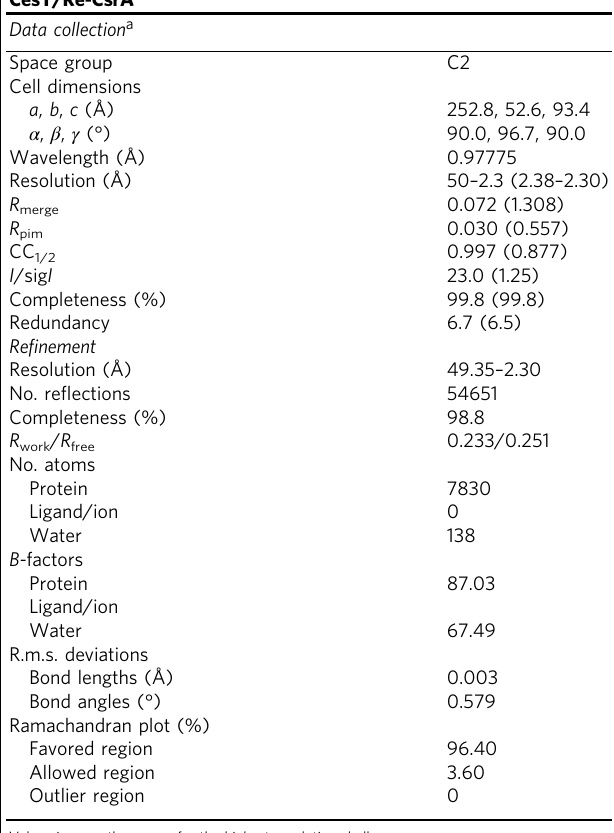
Table 1 Data collection and structure re fi nement statistics